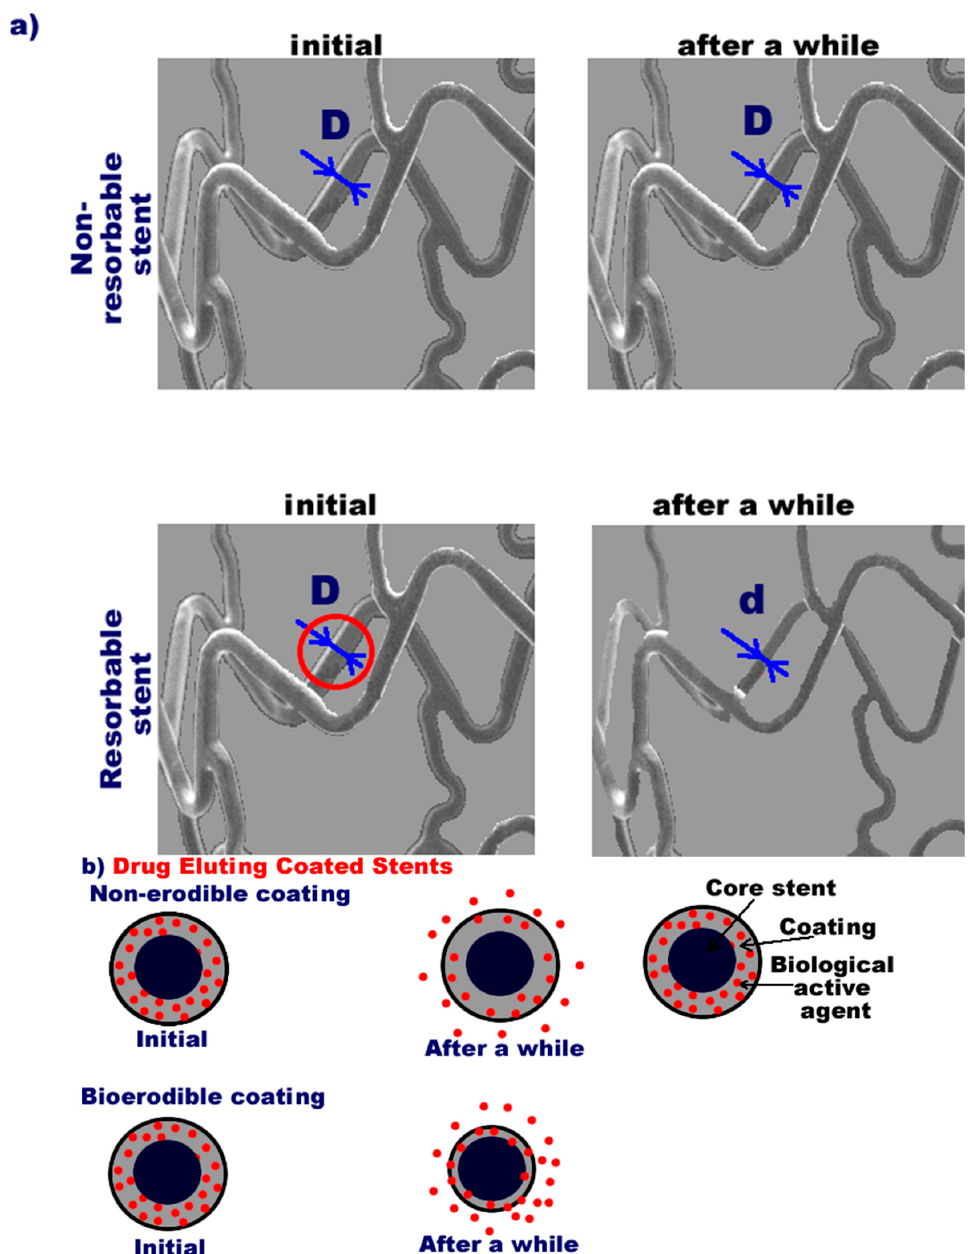
Figure 2. Schematic behavior of bioresorbable and non-bioresorbable stent after implantation ( a ) and mechanisms of drug elution ( b ).